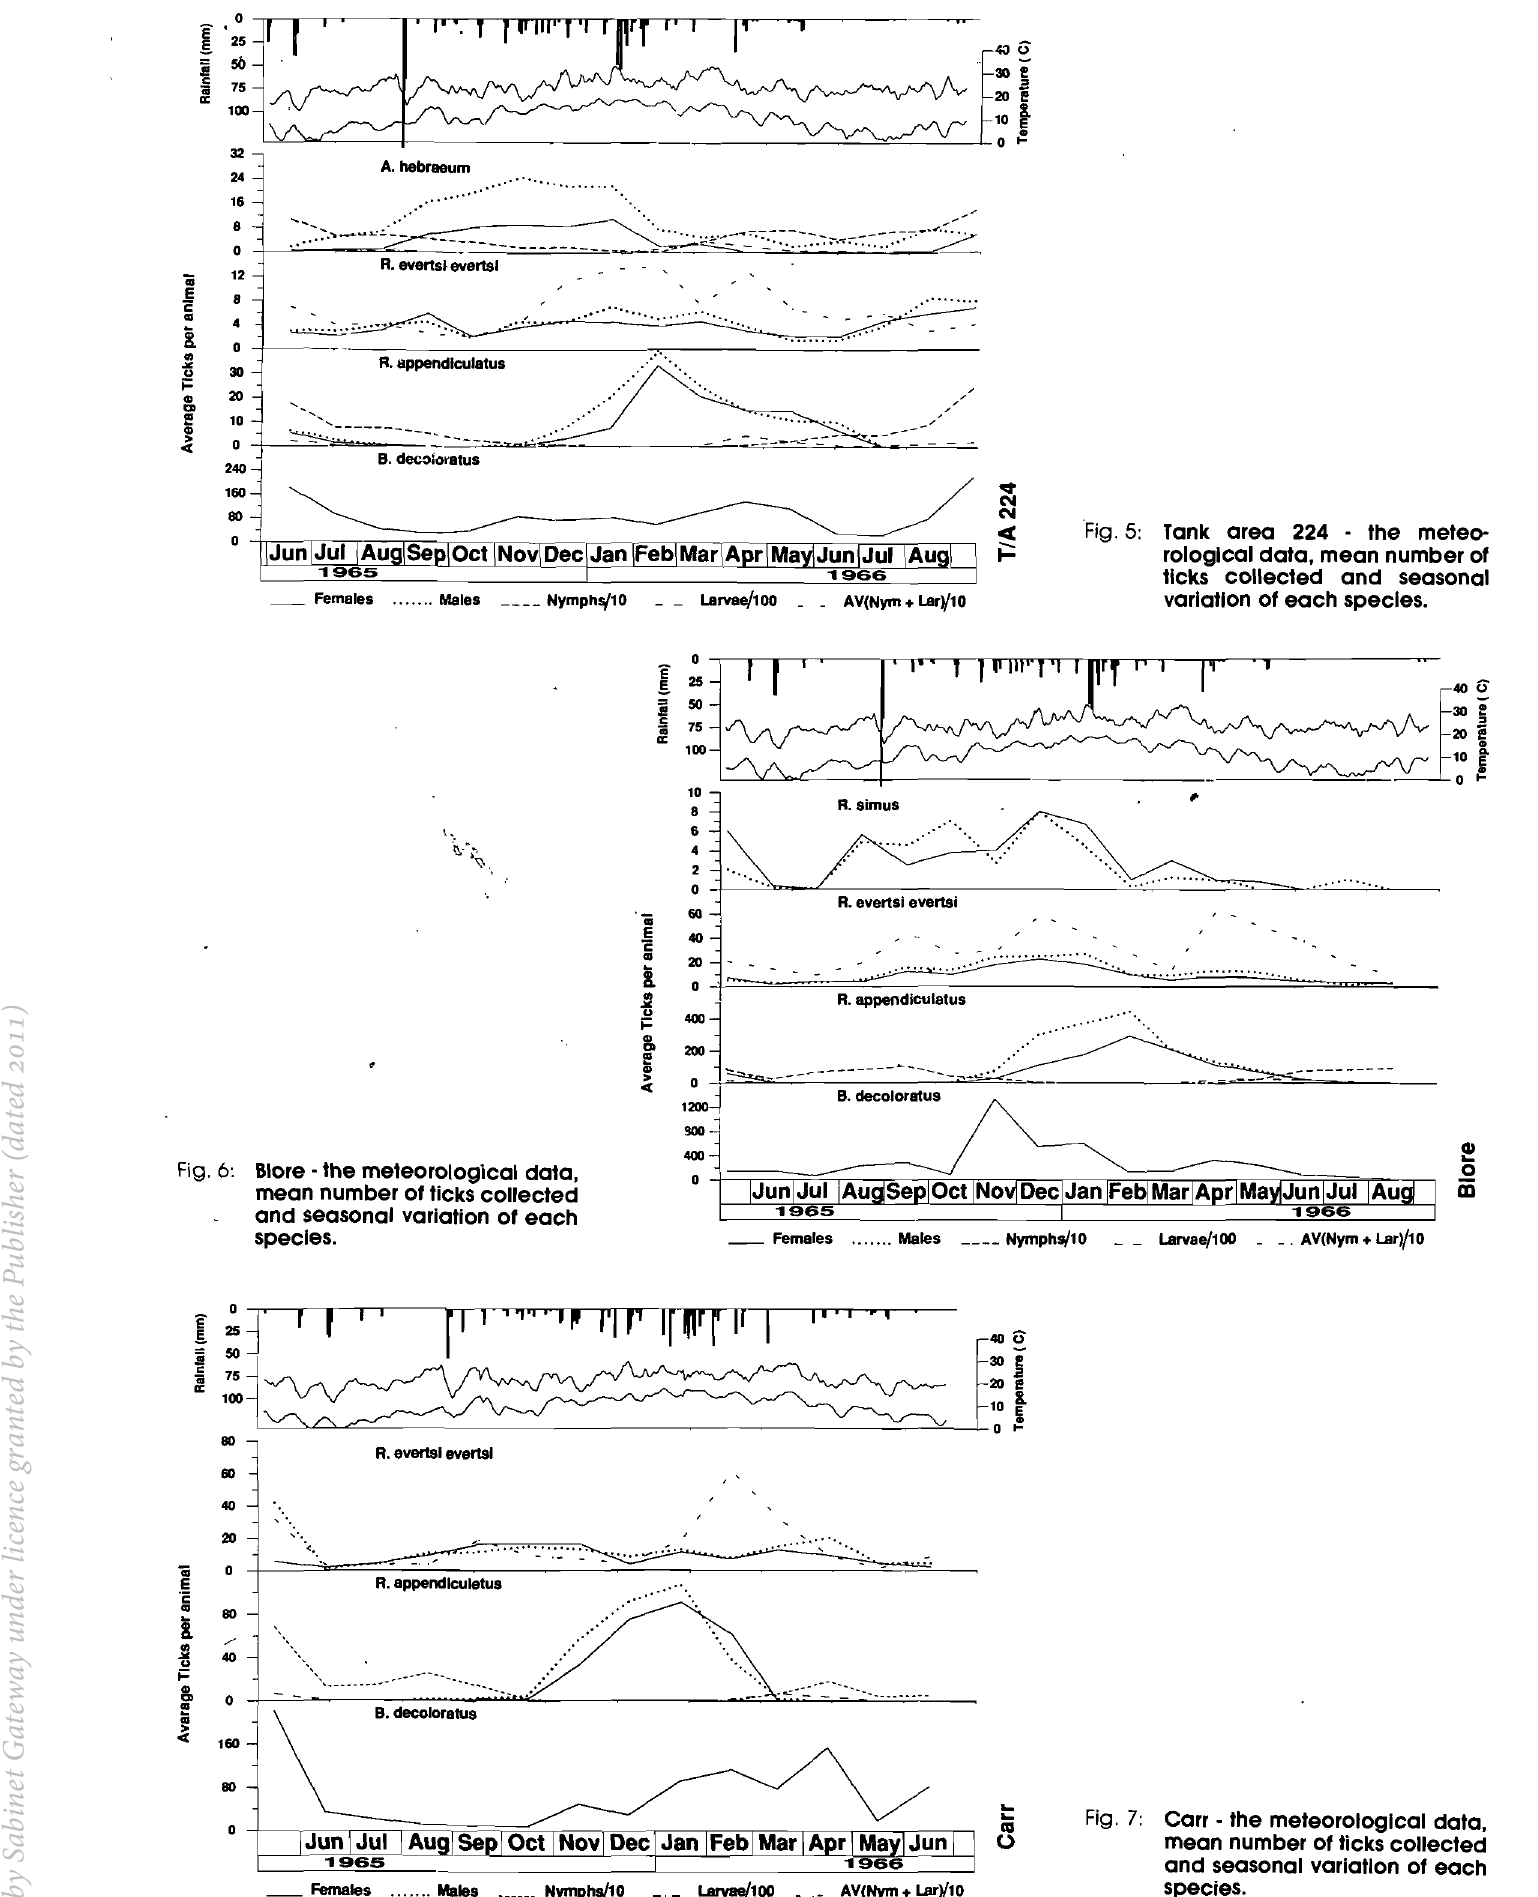
Fig. 7: Carr· the meteorological data, mean number of ticks collected and seasonal variation of each